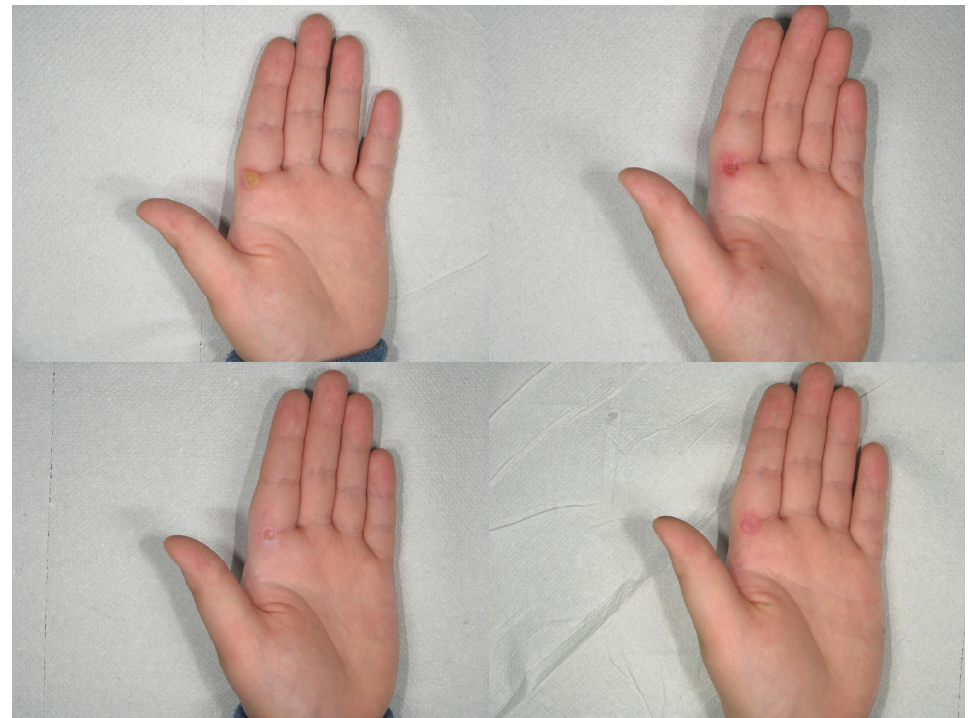
Figure 5. Patient n. 19 before treatment ( upper left ), immediately after CO 2 treatment ( upper right ), immediately after combined treatment ( lower left ), and 1 month after treatment ( lower right ).